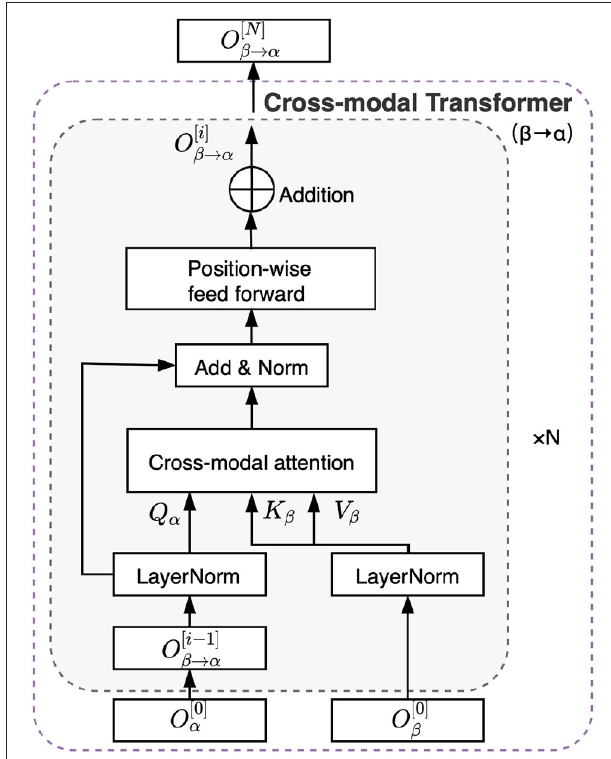
FIGURE 3 | Illustration of the cross-modal transformer architecture between two time-series from modality α and β .